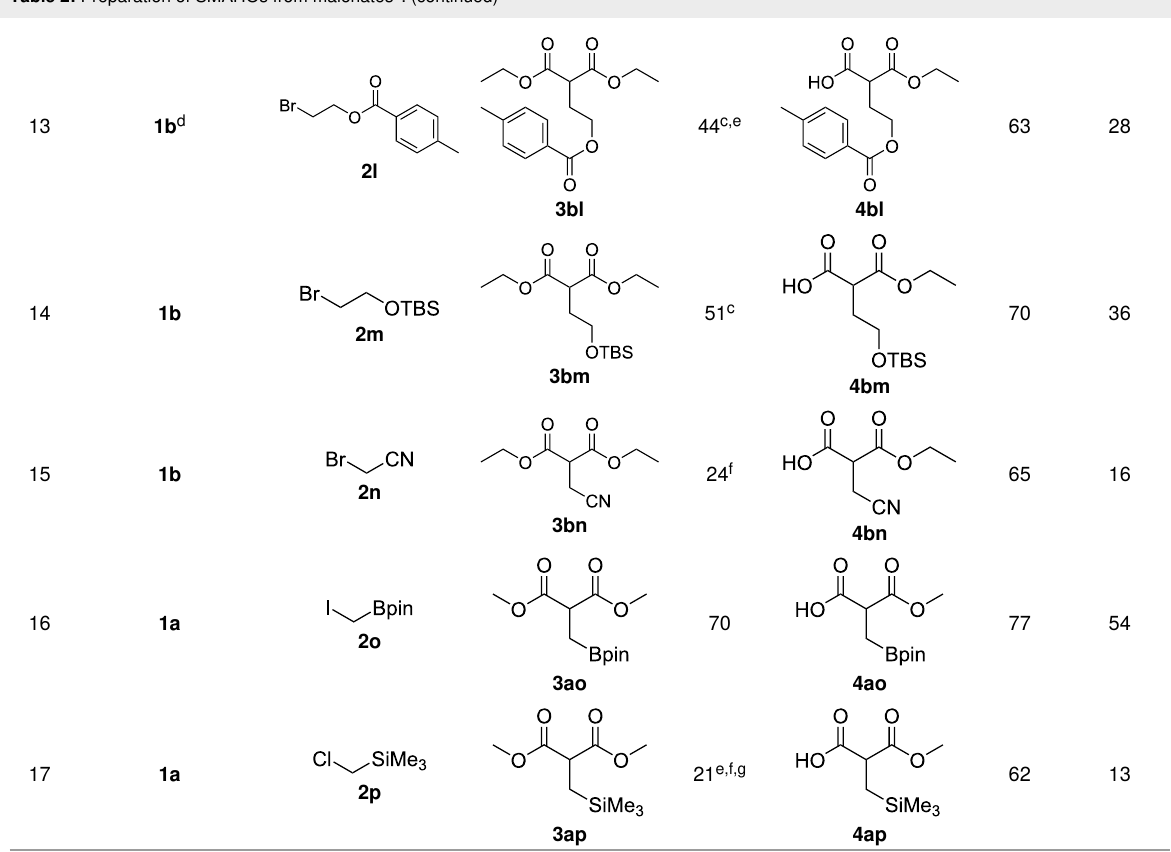
Table 2: Preparation of SMAHOs from malonates a . (continued)